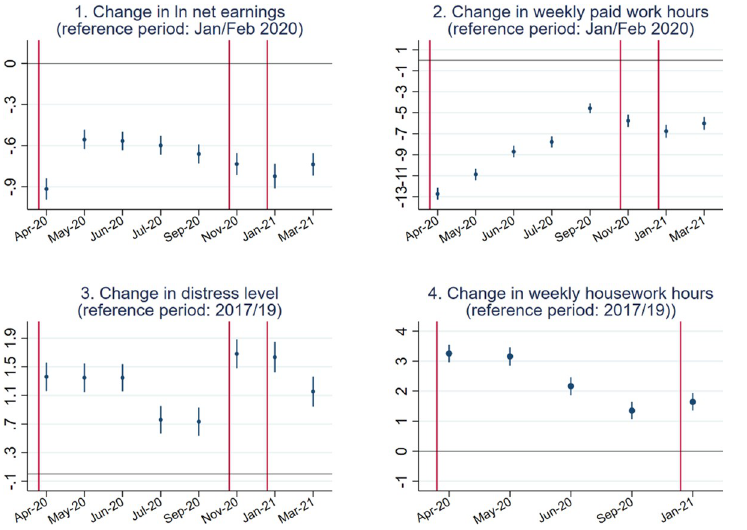
Fig 2. Point estimates and 95% confidence interval of the baseline